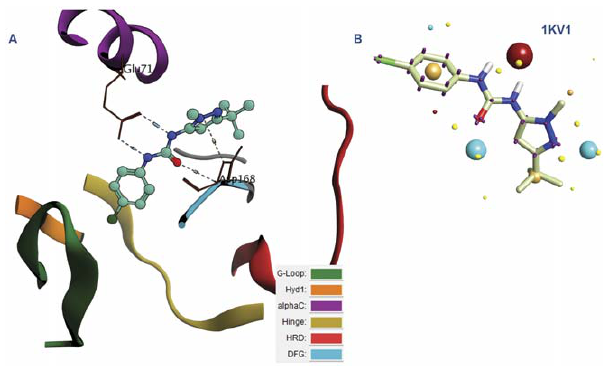
Figure 5. P38 MAP Kinase in Complex with urea-based inhibitor (1KV1): (A) The color codes represent the different regions of the binding site: G-loop, Hyd1, alphaC, Hinge, HRD and DFG regions. The urea fragment binds to the DFG and alphaC regions. (B) The corresponding field template derived from the complex. Color codes of the field template are listed in the supplementary data (Text S2).